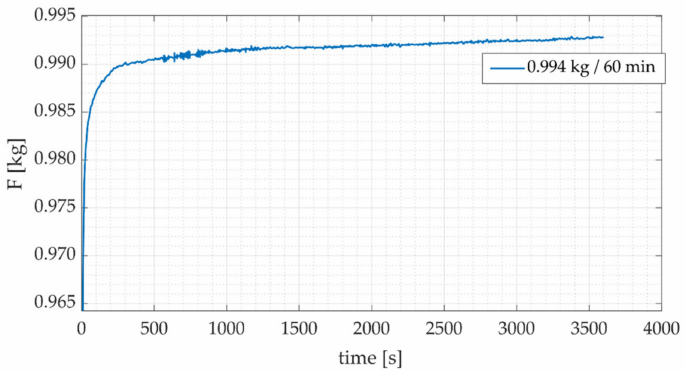
Figure 10. Force measurement for 0.994 kg.